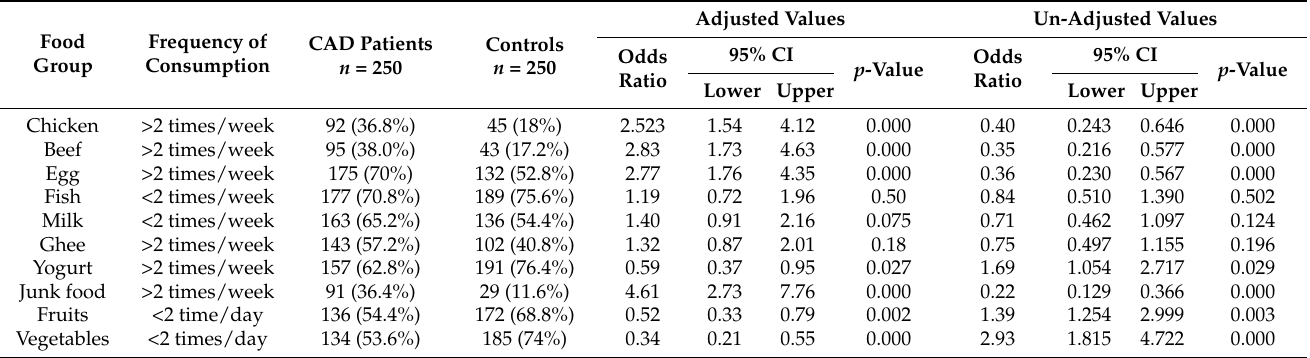
Table 4. Adjusted odds ratio (95% CL) for dietary patterns among coronary artery disease patients and healthy